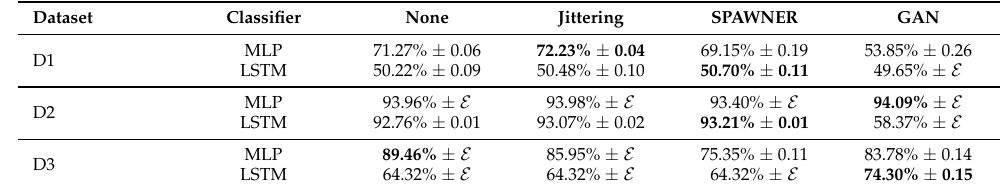
Table 2. Classification accuracy on the test sets derived from each selected dataset. Results are given in terms of means and standard deviations over 10 runs of the classification ( results are presented in bold.